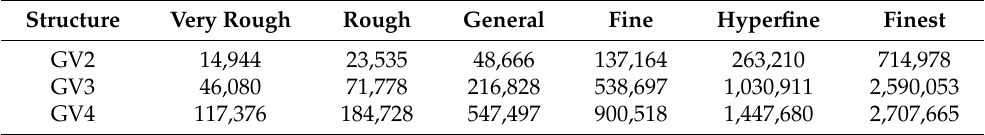
Table 4. The results of meshing different structures with different mesh